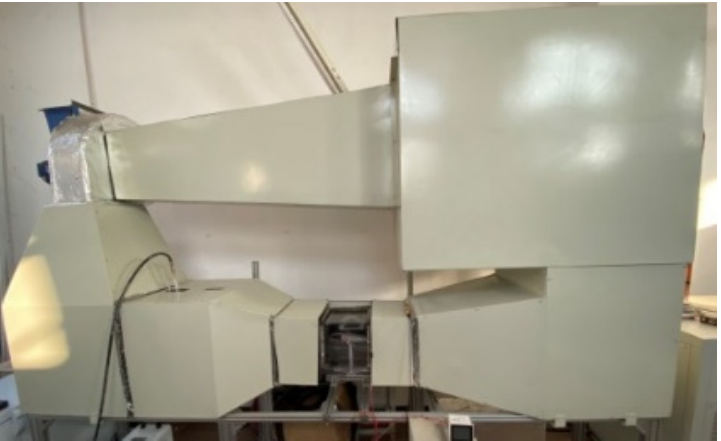
Figure 8. Icing wind